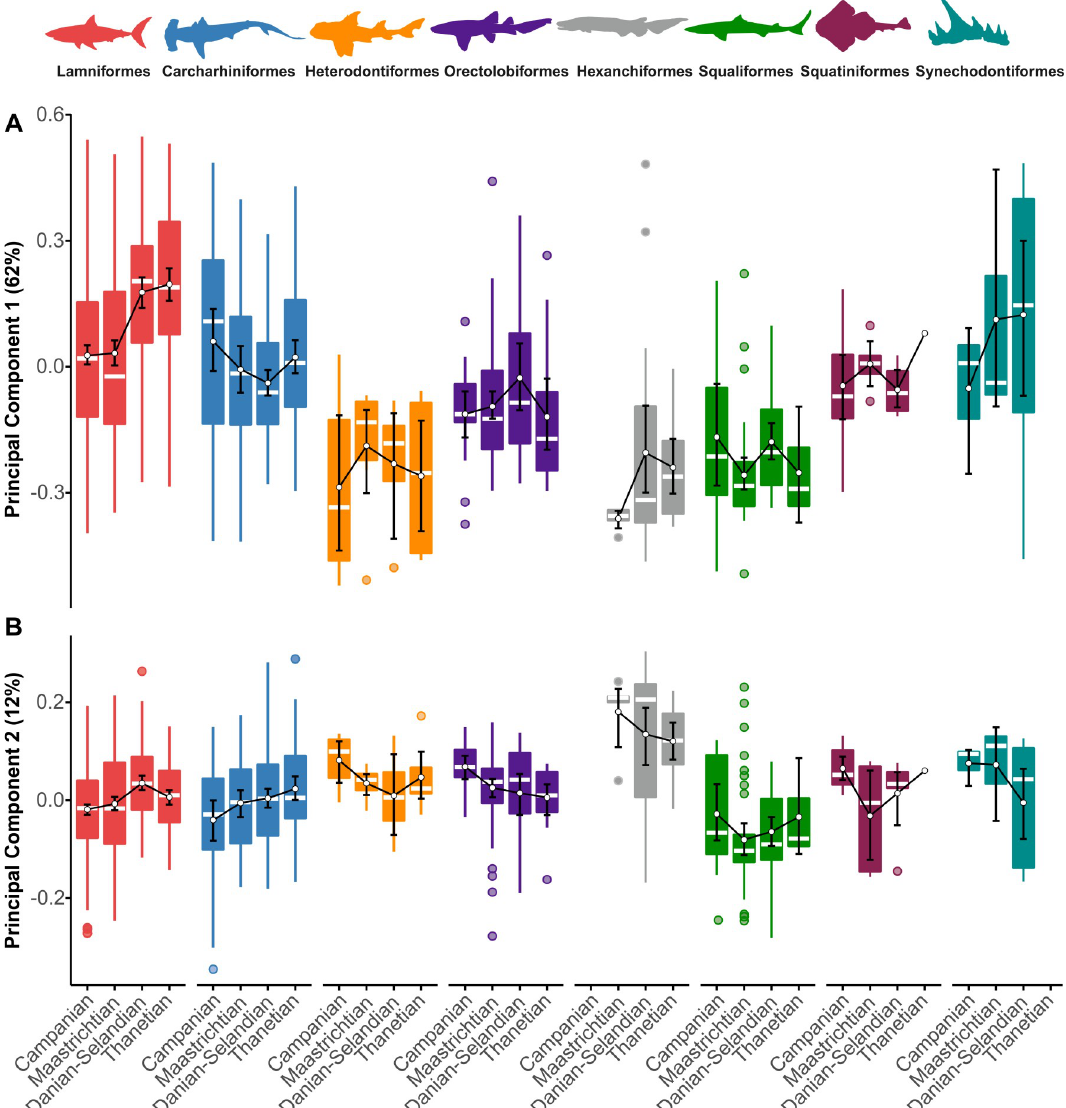
Fig 10. Order-level clade morphospace using the 4-age time-binning scheme. (A, B) Patterns along PC1 and PC2. Sampling was insufficient to estimate reliable disparity for Echinorhiniformes. Measures of central tendency, including the median and arithmetic mean, are shown with computed 95% nonparametric bootstrap confidence intervals and potential outliers. Silhouette graphics created by MB and Julius Csotonyi (https://csotonyi.com/). The data used in this analysis can be accessed online at https://doi.org/10.5061/